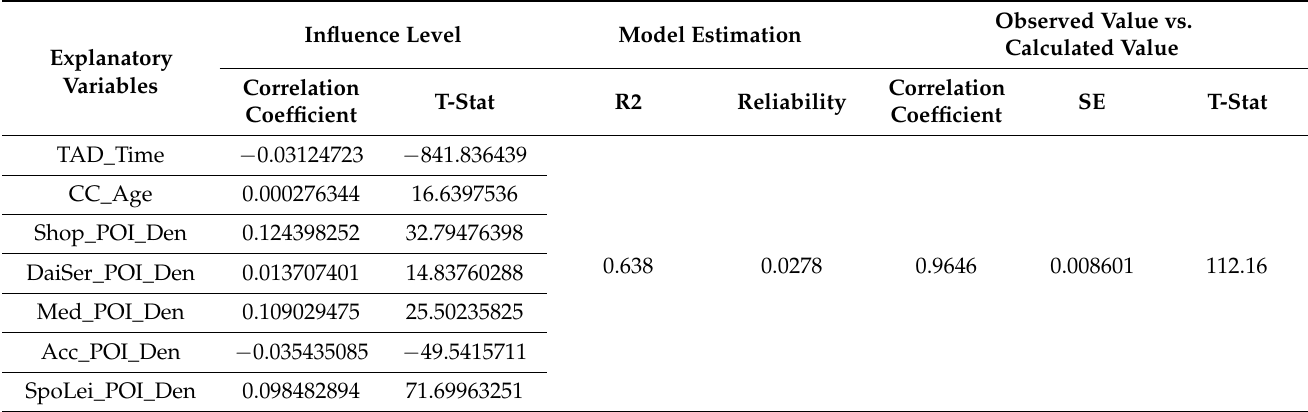
Table 4. Modeling results for consumers of all ages.